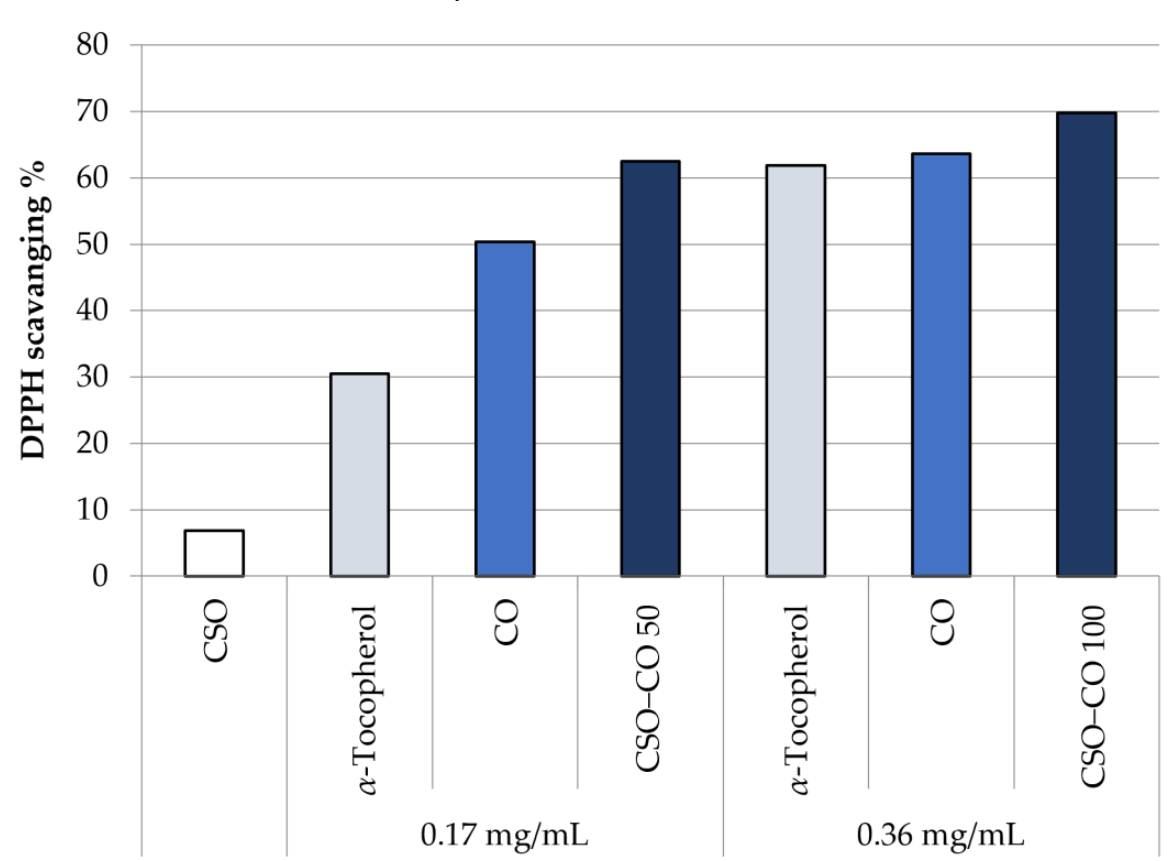
Figure 7. DPPH scavenging effect of the unloaded CSO NE, α -tocopherol, free clove oil (CO), and CO encapsulated in NEs at two concentrations (CSO – CO 50 and CSO – CO 100) (mean ± sd; n = 3).